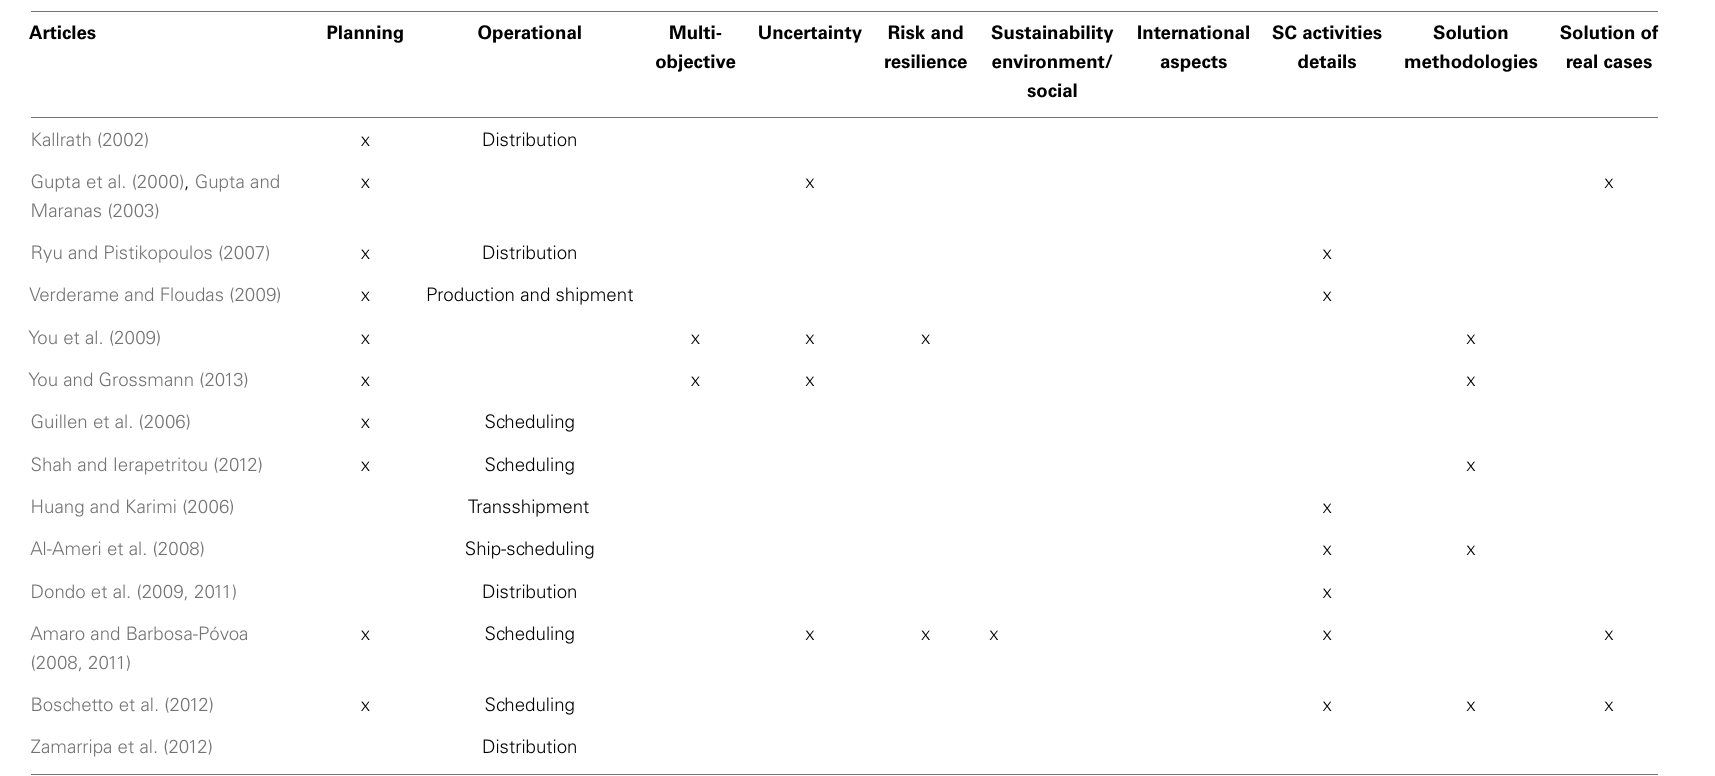
Table 3 | Main contributions on supply chain tactical and operational aspects